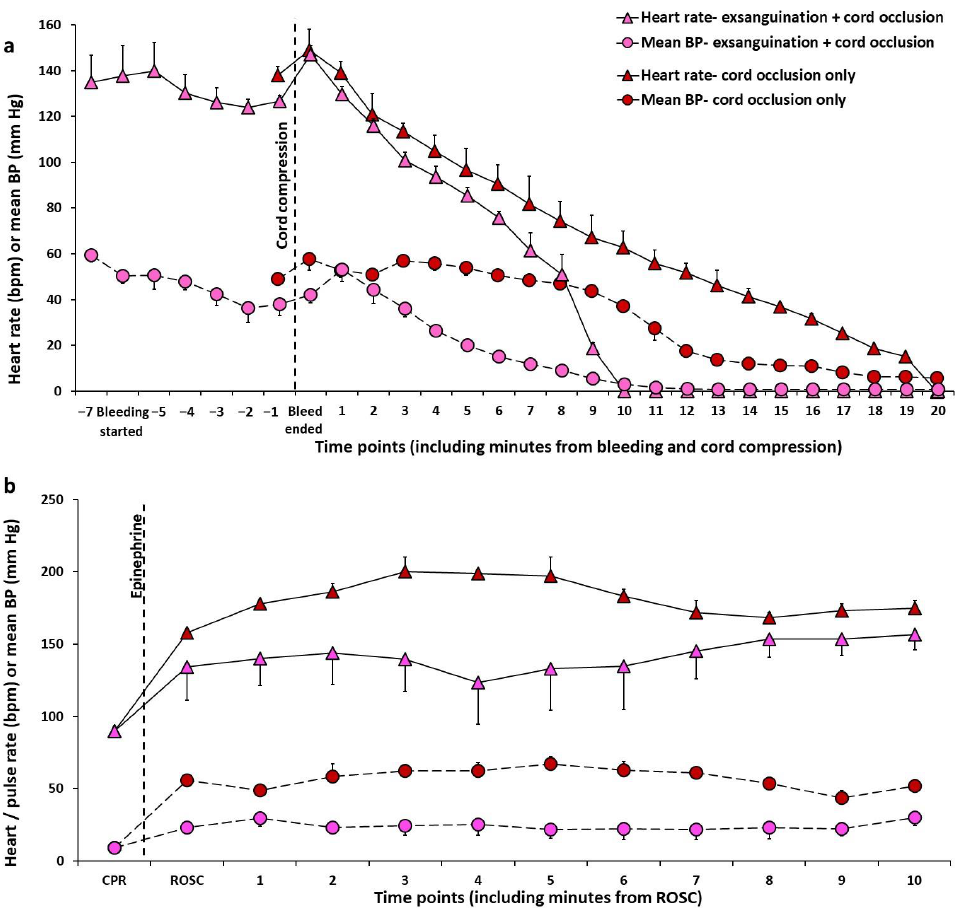
Figure 3. Changes in heart rate (beats per min, bpm) and mean blood pressure (mean BP, mm Hg) during exsanguination followed by cord occlusion in an ovine model ( a , b ), and during asphyxia by cord occlusion ( a , b ). The heart rate and mean BP decrease quickly and dramatically in hypovolemic cardiac arrest ( a ) with slower return to baseline after return of spontaneous circulation ( b ). Copy- right Deepika Sankaran. Table 1. Summary of animal studies evaluating volume replacement in the delivery room.